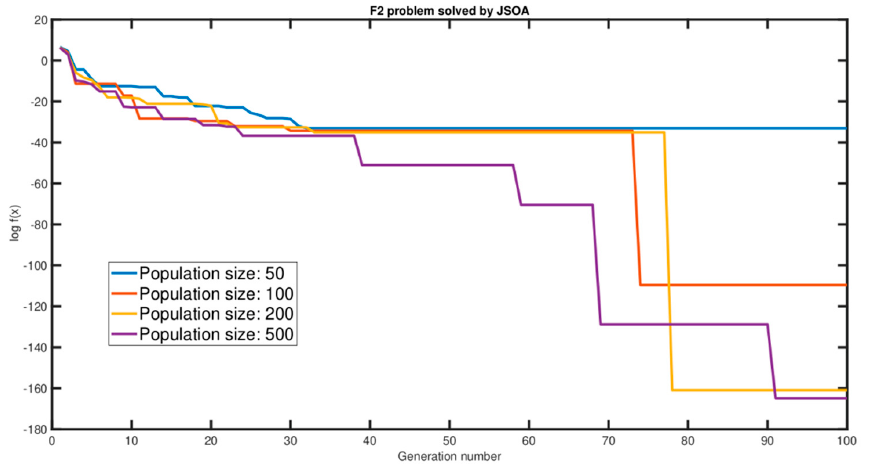
Figure 7. Convergence graph of population size analysis.